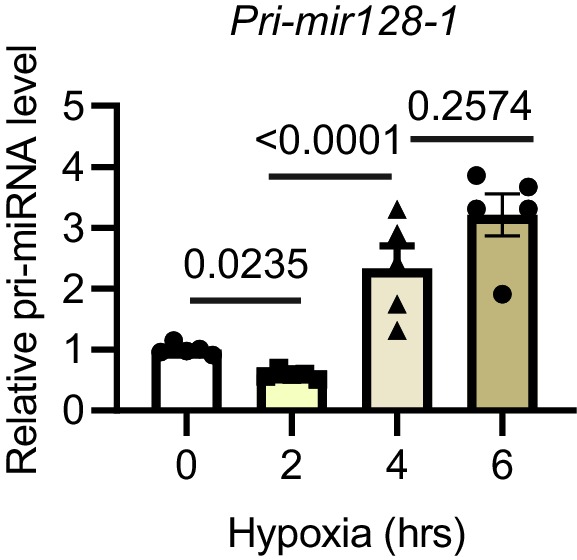
Pri-mir128-1 level in rat cardiomyocytes after hypoxia.Pri-mir128-1 in cardiomyocytes was performed using TaqMan Gene expression (N = 5 experiments). Data were normalised against 18S expression. Data presented as mean ± SEM. Groups were compared using one-way ANOVA followed by Bonferroni post hoc tests.Figure 2—figure supplement 4—source data 1.Pri-mir128-1 level in rat cardiomyocytes after hypoxia.